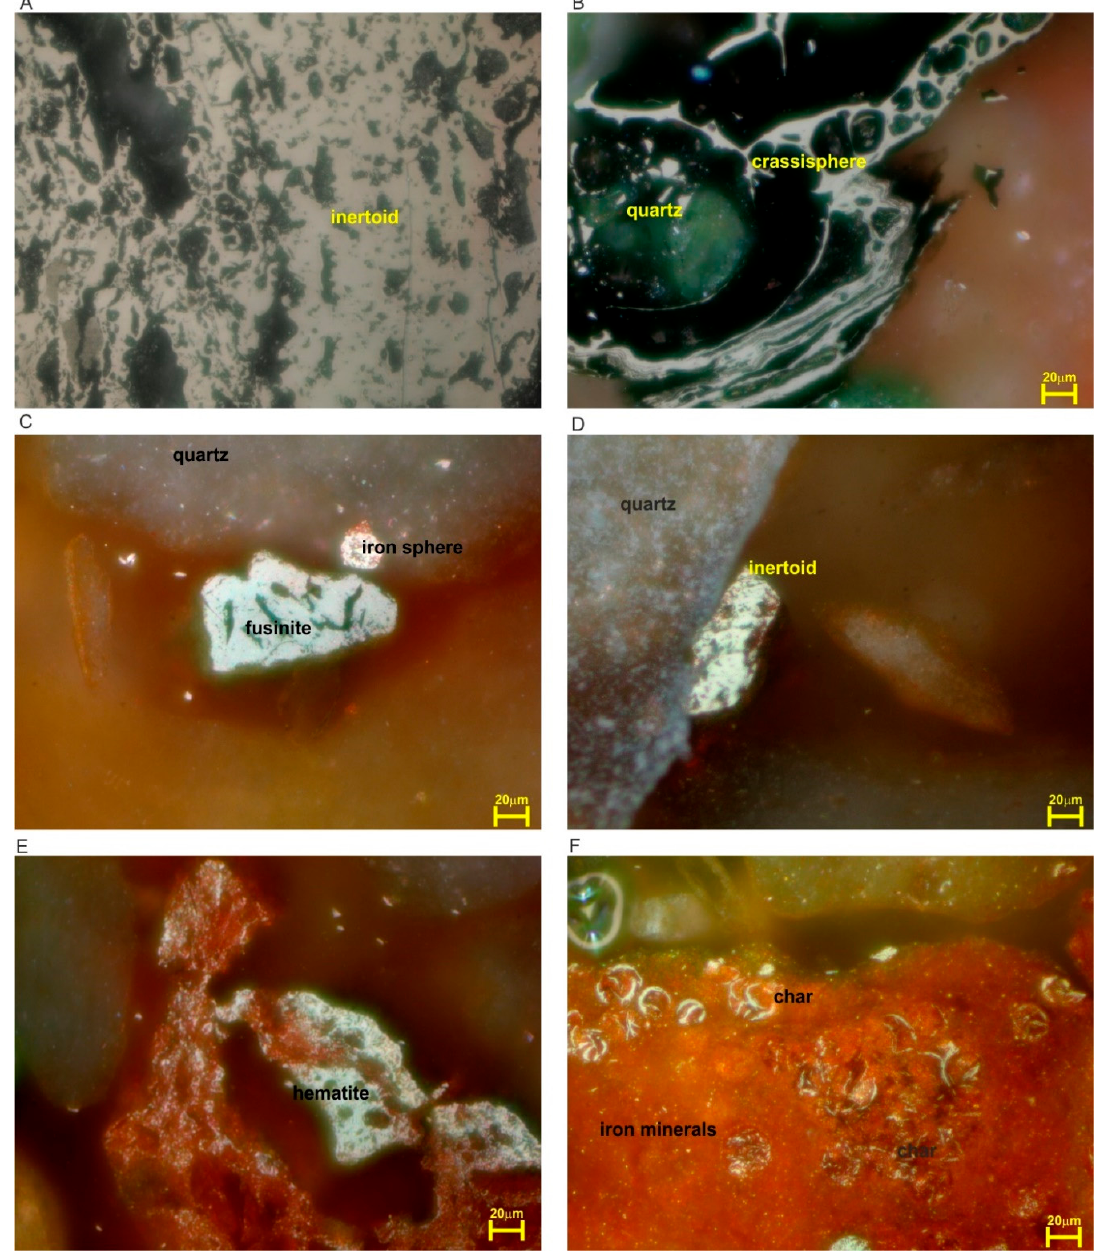
Figure 11. Microscopic image of bottom ash from the combustion of gasification residue resulting from the gasification of coal from the Janina deposit: ( A ) Inertoid, ( B ) crassisphere, ( C ) fusinite-like chip with quartz and an iron sphere, ( D ) inertoid with quartz, ( E ) hematite, ( F ) iron minerals with parts of chars. Reflected light, oil immersion.